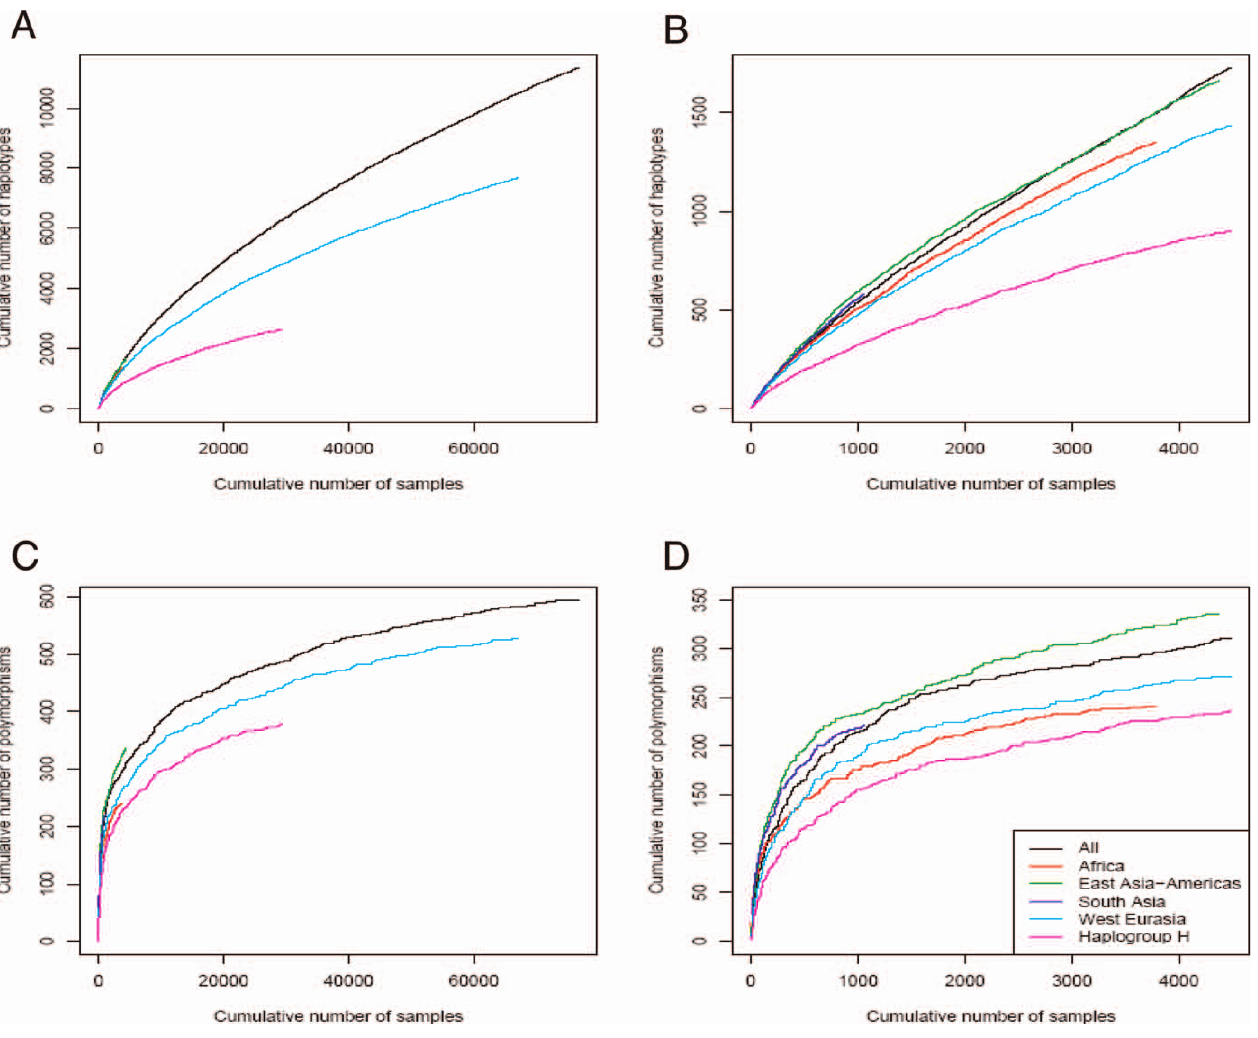
Figure 2. Saturation Curves The number of accumulated mtDNA HVS-I haplotypes (A and B) and polymorphic sites (C and D) as a function of the number of accumulating samples is shown. The analysis is presented once for the entire database (A and C) and once for a limited number of samples (B and D), allowing a better comparison with the less well-represented geographic groups. The Hgs were grossly divided to represent four different geographic groups as follows. Africa: L, M1, and U6; East Asia-Americas: A, B, C, D, F, N9a, and R9; South Asia: M*, R1, R2, R5, and R6; and West Eurasia: N1, R, W, and X. Saturation curves for Hg H are also presented.